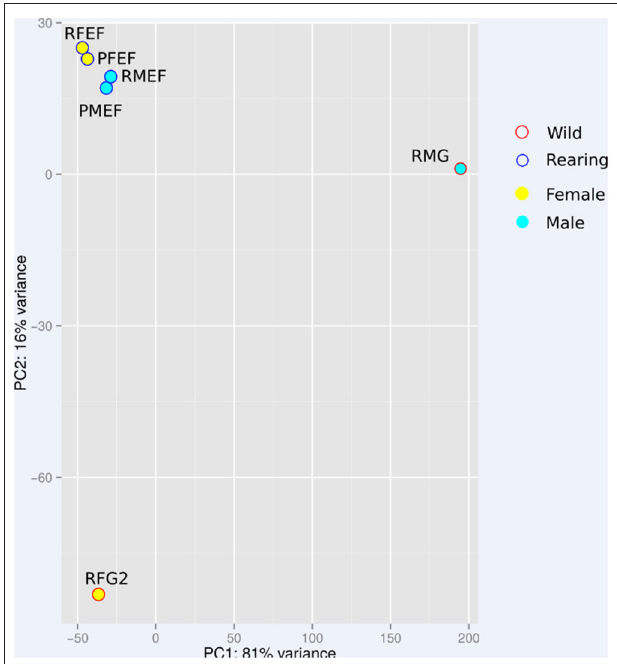
FIGURE 4 | ACP based on count data normalized by the function of rlog DESseq2. see Table 1 for a sample description.